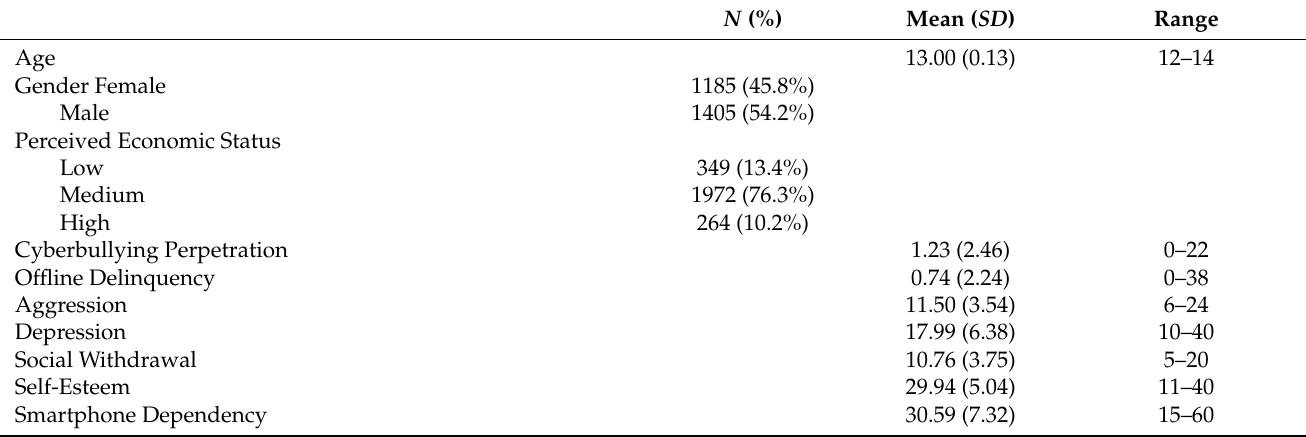
Table 2. Descriptive statistics for the general participant characteristics and study variables ( N =